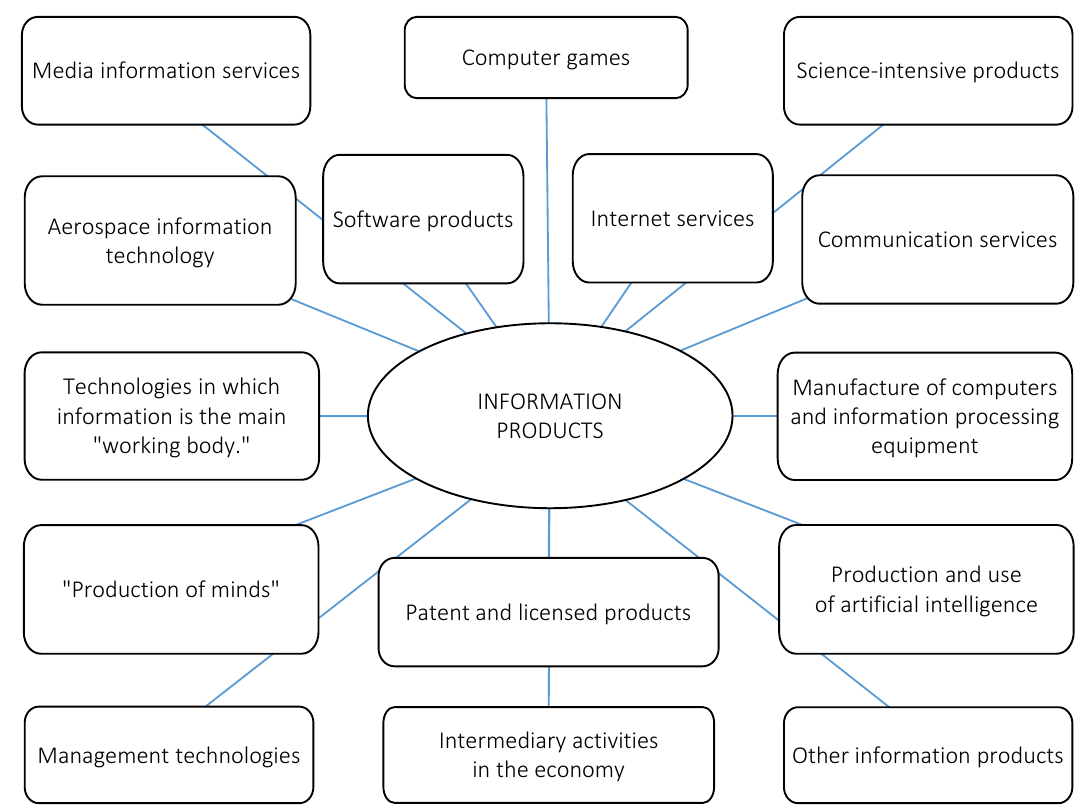
Figure 2. Some types of modern information